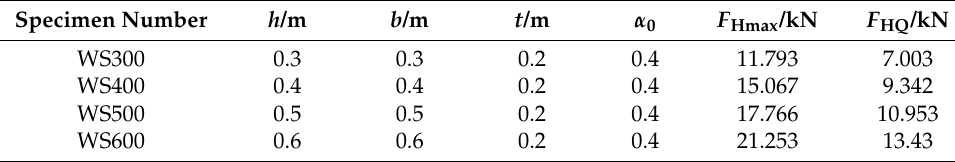
Table 2. Fracture test results reported in reference [56].